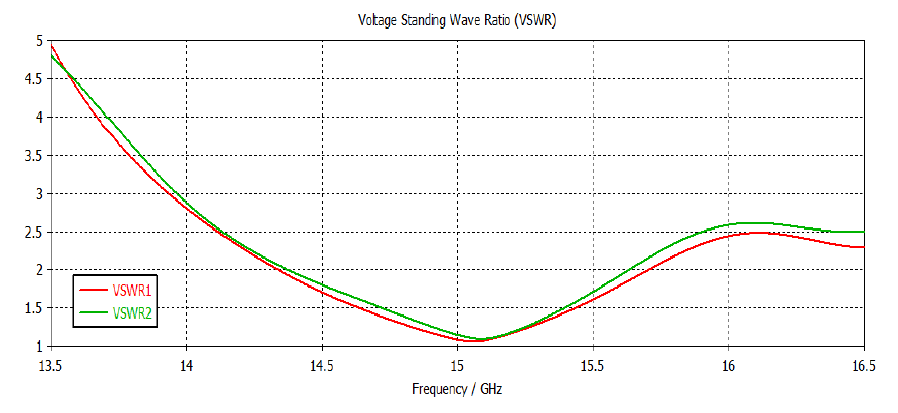
Fig. 6. Simulation results – antenna array VSWR.